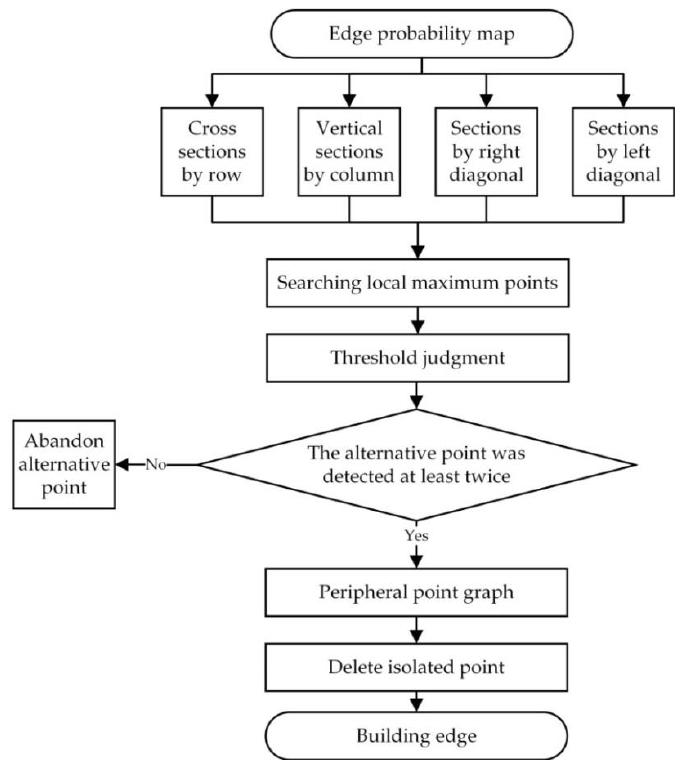
Figure 7. Workflow of edge probability map refinement.